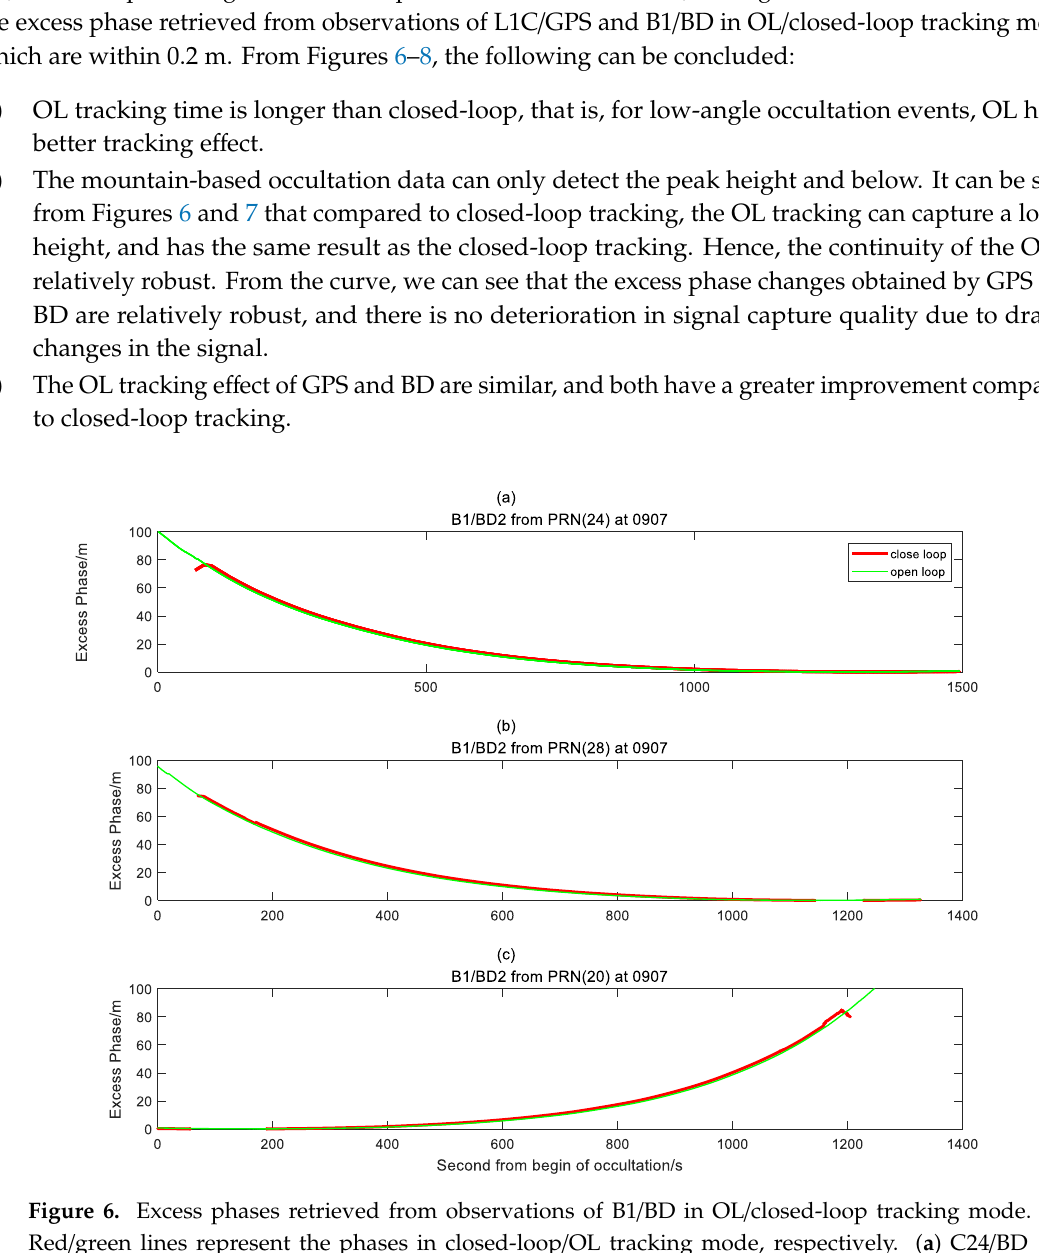
Figure 7. Excess phase retrieved from observations of L1C/GPS in OL/closed-loop tracking mode. Red/green lines represent the phases in closed-loop/OL tracking mode, respectively. ( a ) G19/GPS occultation; ( b ) G24/GPS occultation; and ( c ) G12/GPS occultation.